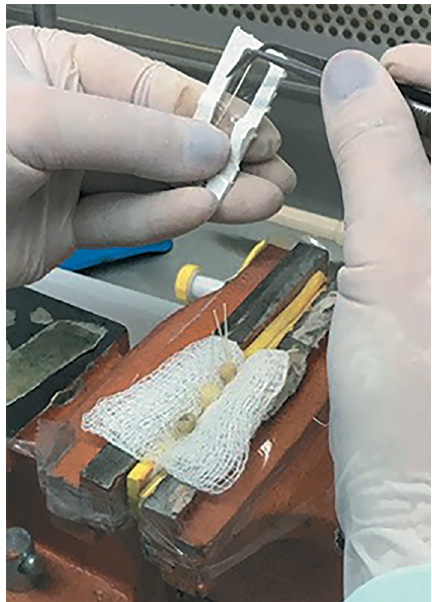
Figure 2. Eppendorf tube with the paper point after